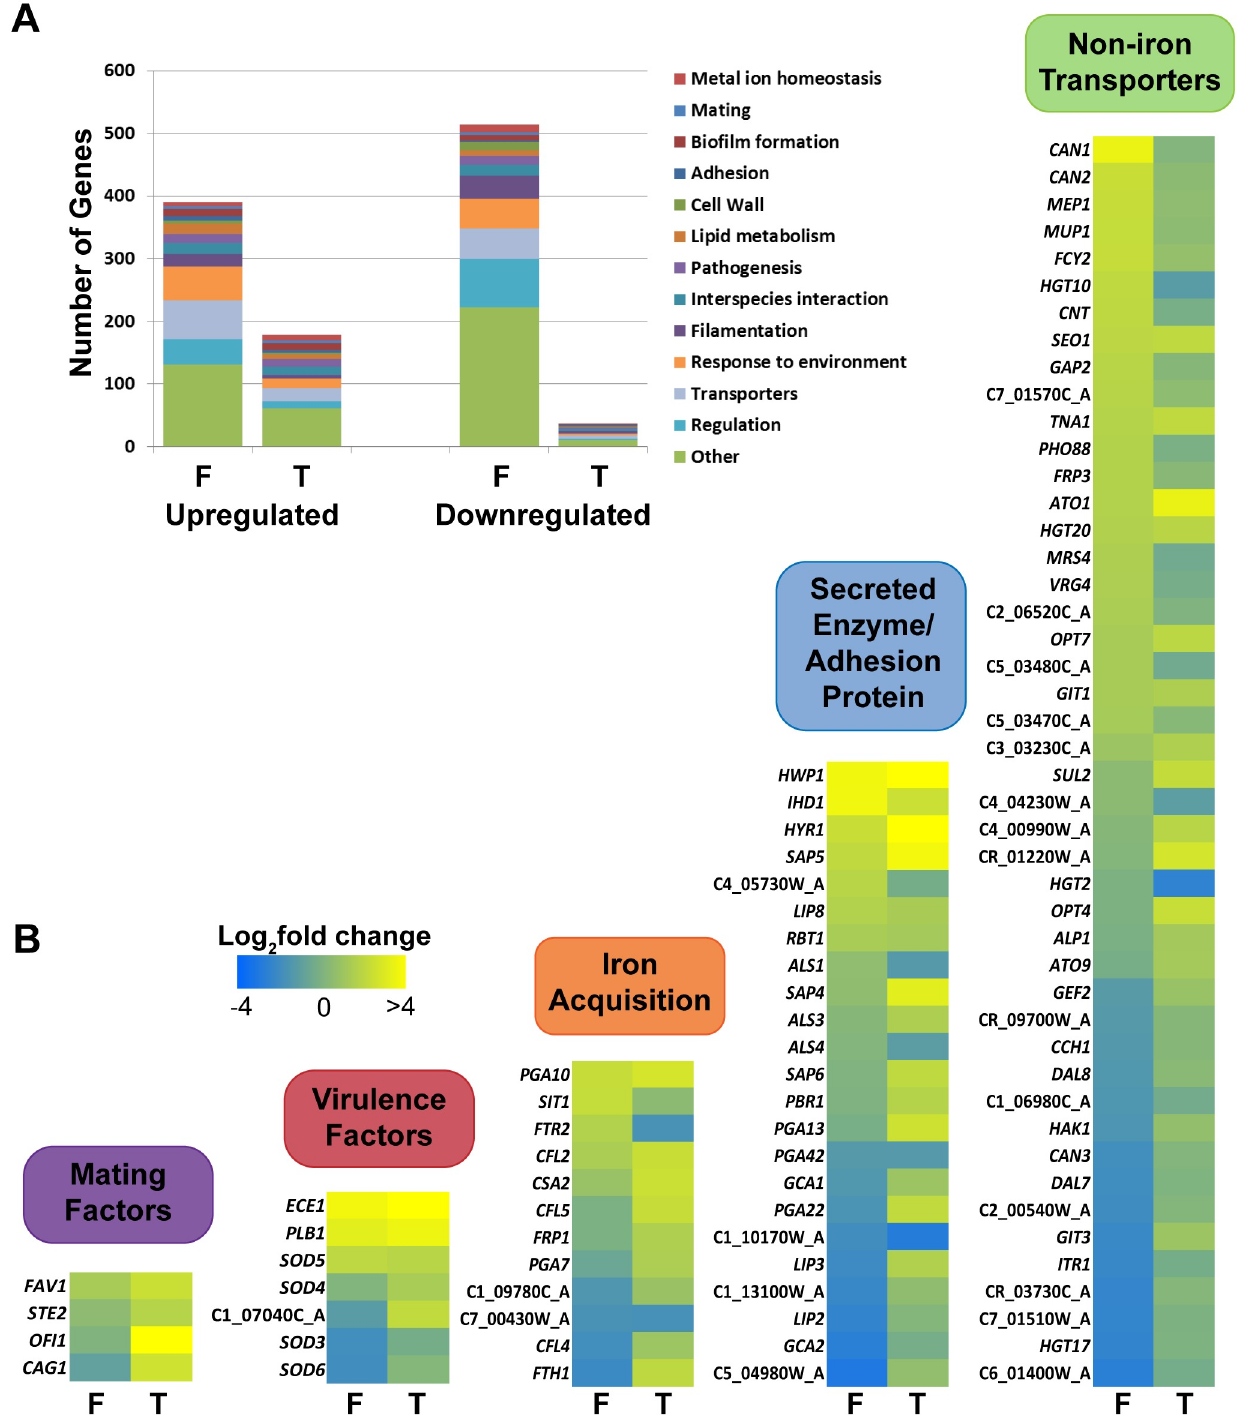
Fig 2. Flow induces more numbers of C . albicans genes having changes in expression level than does temperature. RNA-seq was performed on Candida albicans wild-type (WT) CAI4 cells grown under microcolony inducing conditions (37˚C with flow) and compared to non-microcolony biofilms grown at 37˚C without flow ( F ; 654 gene expression changes) or at 23˚C with flow ( T ; 142 gene expression changes). ( A ) Gene ontology analysis of both RNA-seq datasets, generated from the Candida Genome Database. Genes may map to multiple ontological categories. ( B ) Differentially regulated genes from both RNA-seq datasets were hand annotated into five unique categories, with heatmaps of the expression data being shown. Genes with significantly different (Cuffdiff, P < 0.05) changes in transcript levels in at least one dataset are shown.